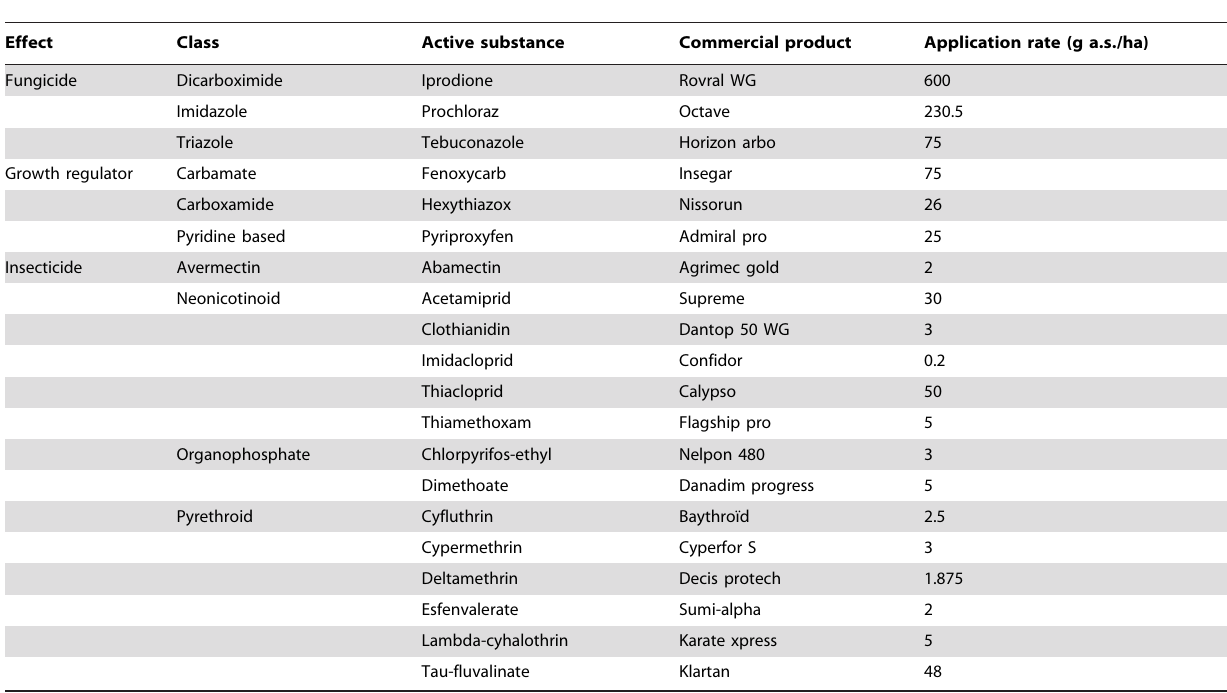
Table 1. Summary of commercial products and their application rates used for the spraying